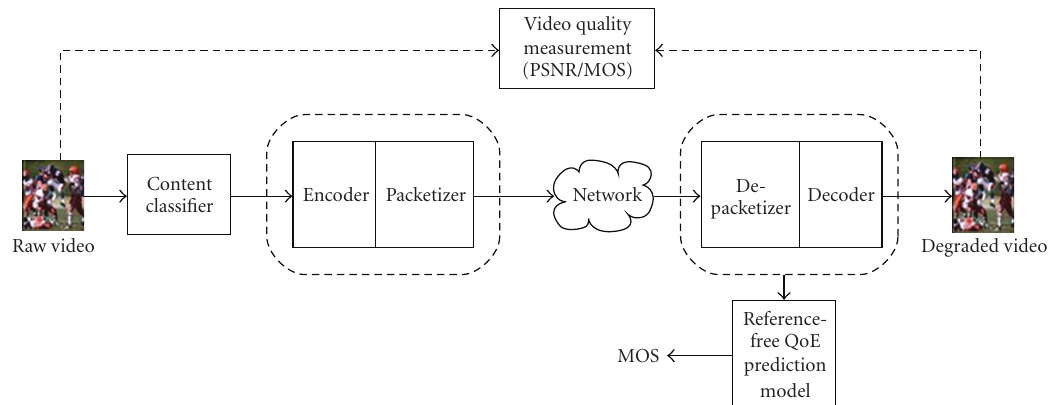
Figure 4: Conceptual diagram to illustrate video quality prediction.